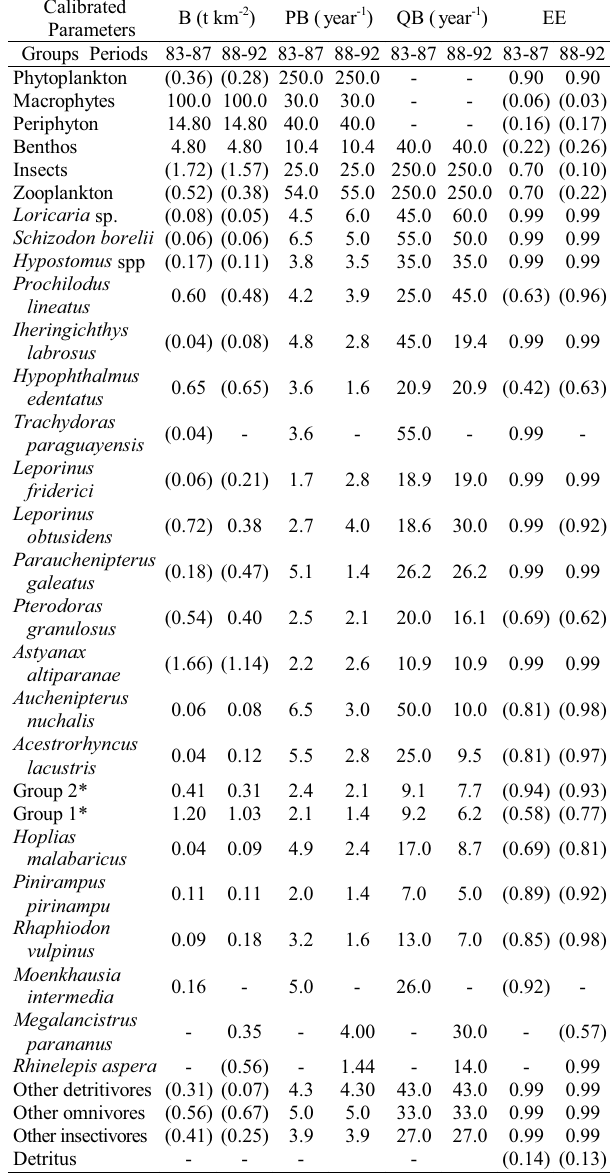
Table 1. Parameters of the ECOPATH models for the Itaipu Reservoir in the two periods: I TAIPU -1 (83-87) and I TAIPU -2 (88-92). B (Biomass); PB (Production/Biomass); QB (Consump- tion/Biomass); EE (Ecotrophic Efficiency). Values in brackets are estimated by Ecopath. * Species Grouping: Group 1: P. maculatus , P. squamosissimus, S. marginatus; Group 2: A. ucayalensis ; Other piscivores, Z. zungaro , P. corruscans . Calibrated